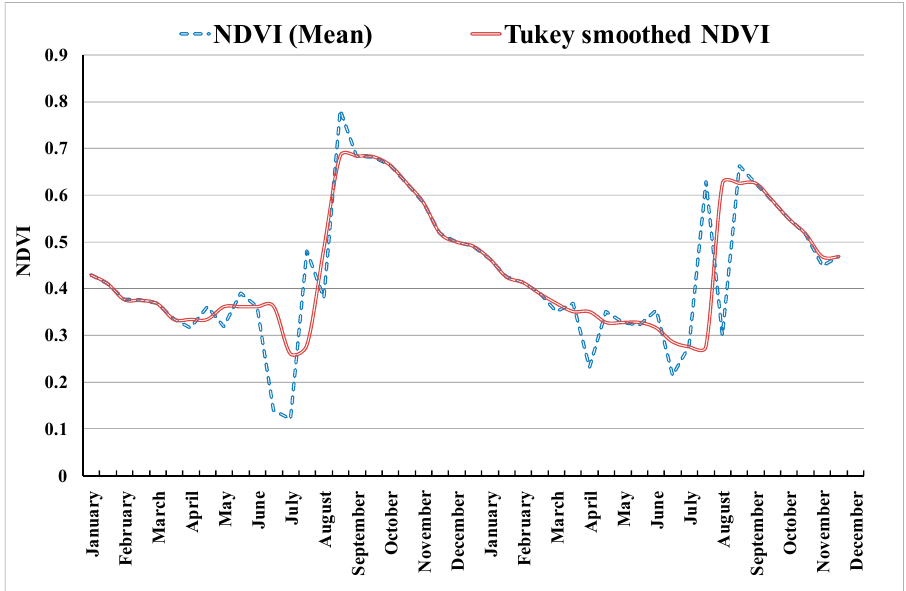
Figure 4. NDVI time series for the year 2013–2014 reconstructed using Tukey’s smoothing.